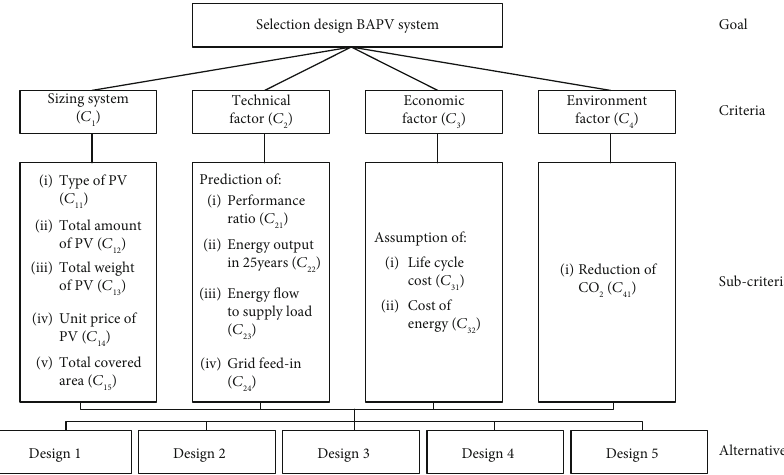
Figure 7: The framework of fuzzy AHP in the proposed